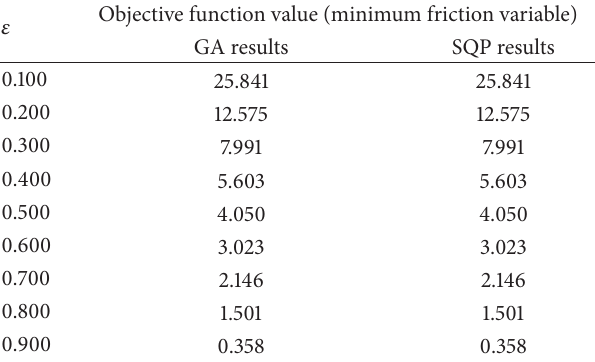
Table 3: Comparison of GA and SQP